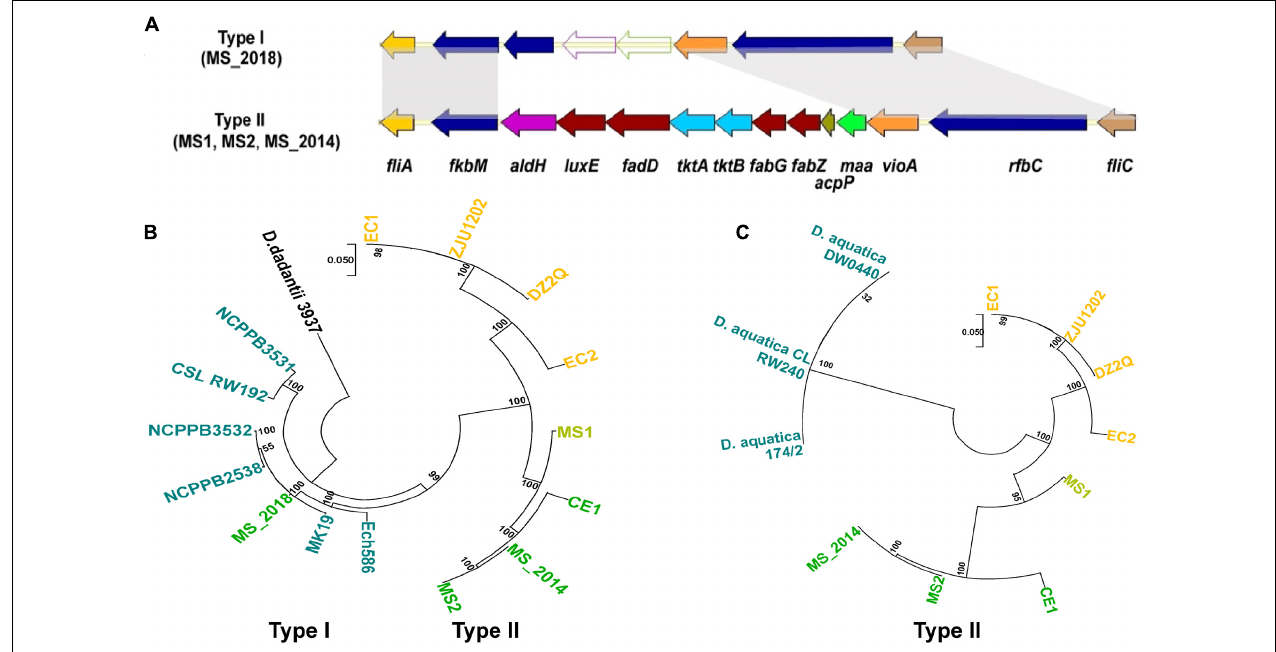
FIGURE 3 | Genomic differentiation of D . zeae strains isolated from banana. (A) Genetic organization of fli / che clusters among D . zeae strains (genes aligned with a shadow are homologous). (B) Phylogenetic dendrogram based on fliZ - flhD genomic sequences of D . zeae strains with a maximum likelihood method and bootstrapped at 1,000 replications, D . dadantii 3937 was used as an out-group control. (C) Phylogenetic dendrogram based on fkbM - rfbC genomic sequences of Dickeya strains inserted with sugar biosynthesis and fatty acid biosynthesis gene